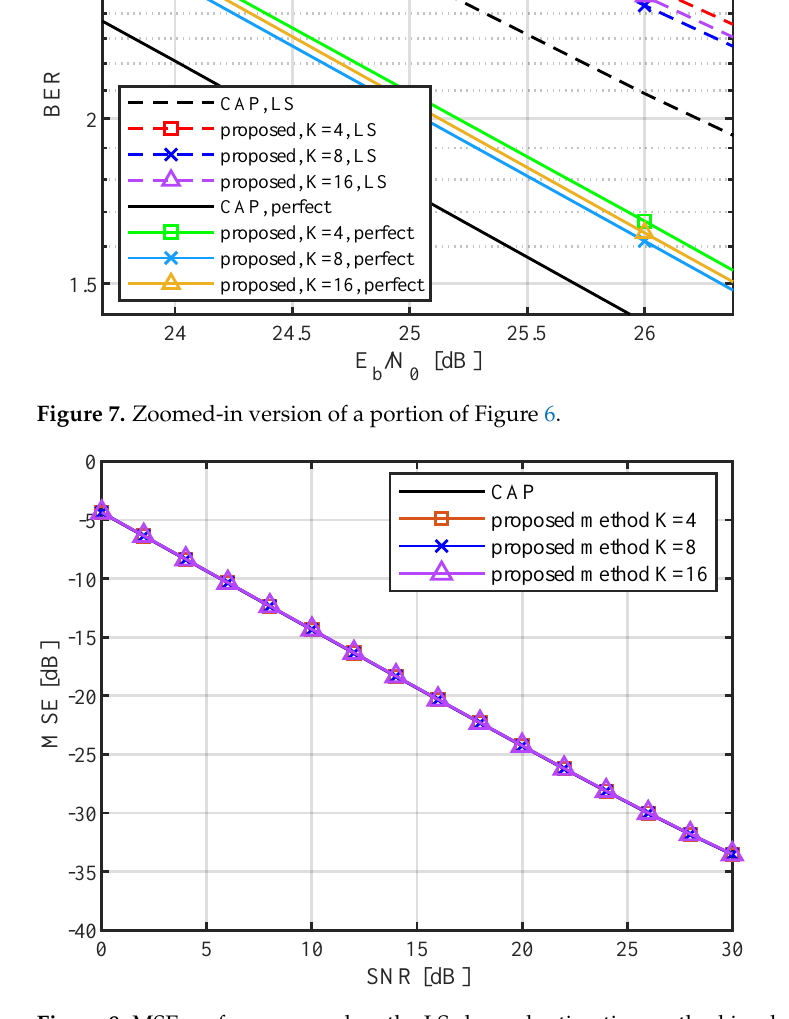
Figure 8. MSE performances when the LS channel estimation method is